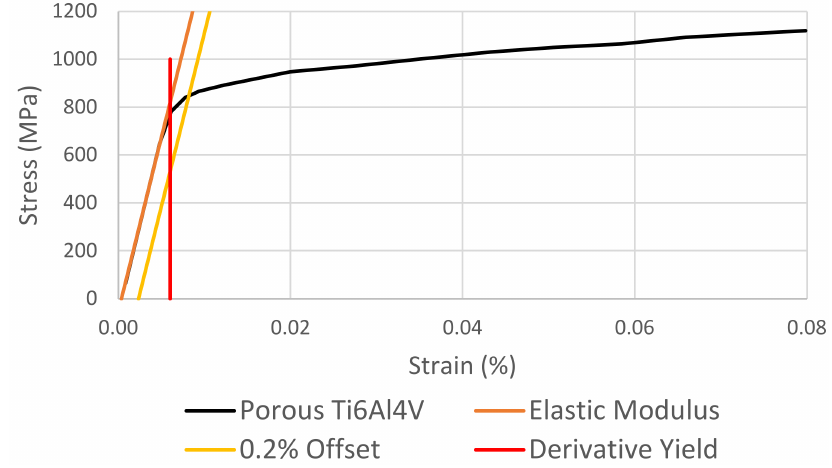
Figure 12. Comparison of the results from the offset yield and the derivative yield as applied to the experimentally measured stress–strain curve for porous Ti6AL4V (porosity 7.6%) subjected to tensile loading. The Strain axis to 0.5 enables the best